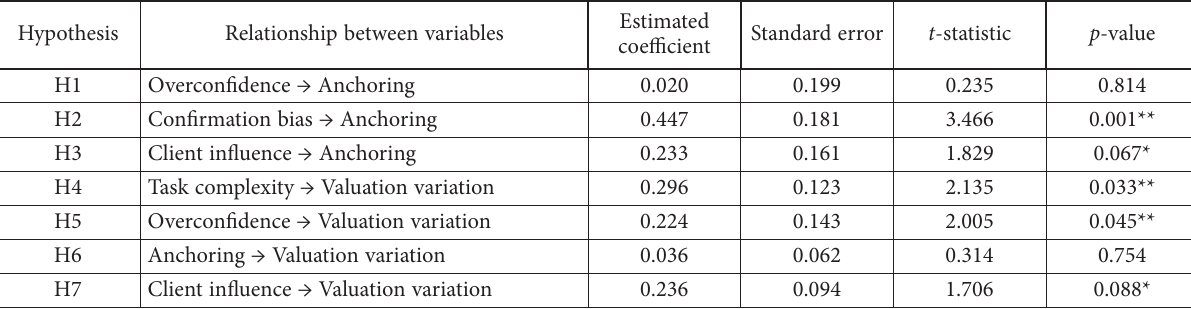
Figure 2. Results of the structural equation Table 7. Estimation results derived from SEM